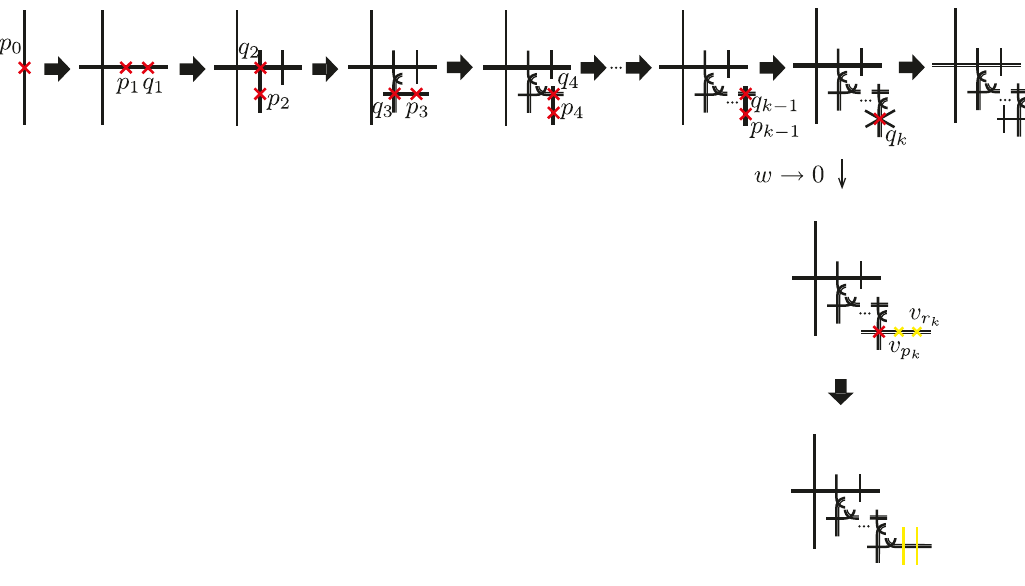
Figure 6 . Singularities and exceptional curves in the split I ∗